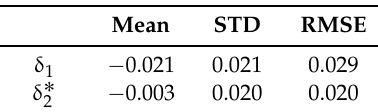
Figure 5. Density plots of EVI differences using the data for the evaluation. ( a ) Density plot of MODIS EVI minus VIIRS EVI ( δ (cid:2869) ) vs. MODIS EVI; ( b ) Density plot of MODIS EVI minus MODIS-compatible VIIRS EVI ( δ (cid:2870) ∗ ) vs. MODIS EVI. Table 4. Statistics of MODIS EVI minus VIIRS EVI ( δ (cid:2869) ) and MODIS EVI minus MODIS-compatible VIIRS EVI ( δ (cid:2870) ∗ ) for the evaluation.